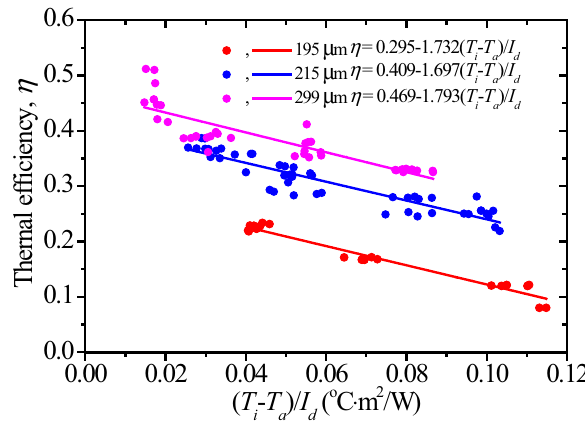
Fig. 8 The thermal efficiency of the PTC using the different thick- nesses of Ni–Al coating on SS tube as solar absorber of receiver tube